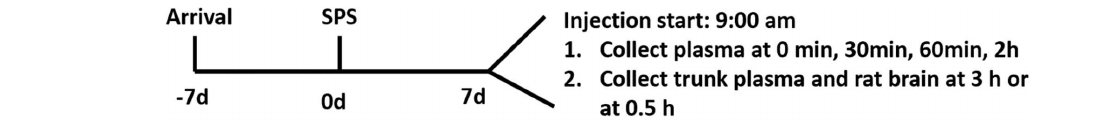
FIGURE 1 | Schematic diagram of the study. Of note, 1 week after arrival in the facility, rats were exposed to single prolonged stress (SPS; day 0); 7 days after SPS, rats were injected with corticosterone or vehicle. In experiment 1, plasma was collected via a tail cut at 0, 30, 60 min, and 2 h. Rats were sacrificed at 3 h (experiment 1) or 0.5 h (experiment 2) after